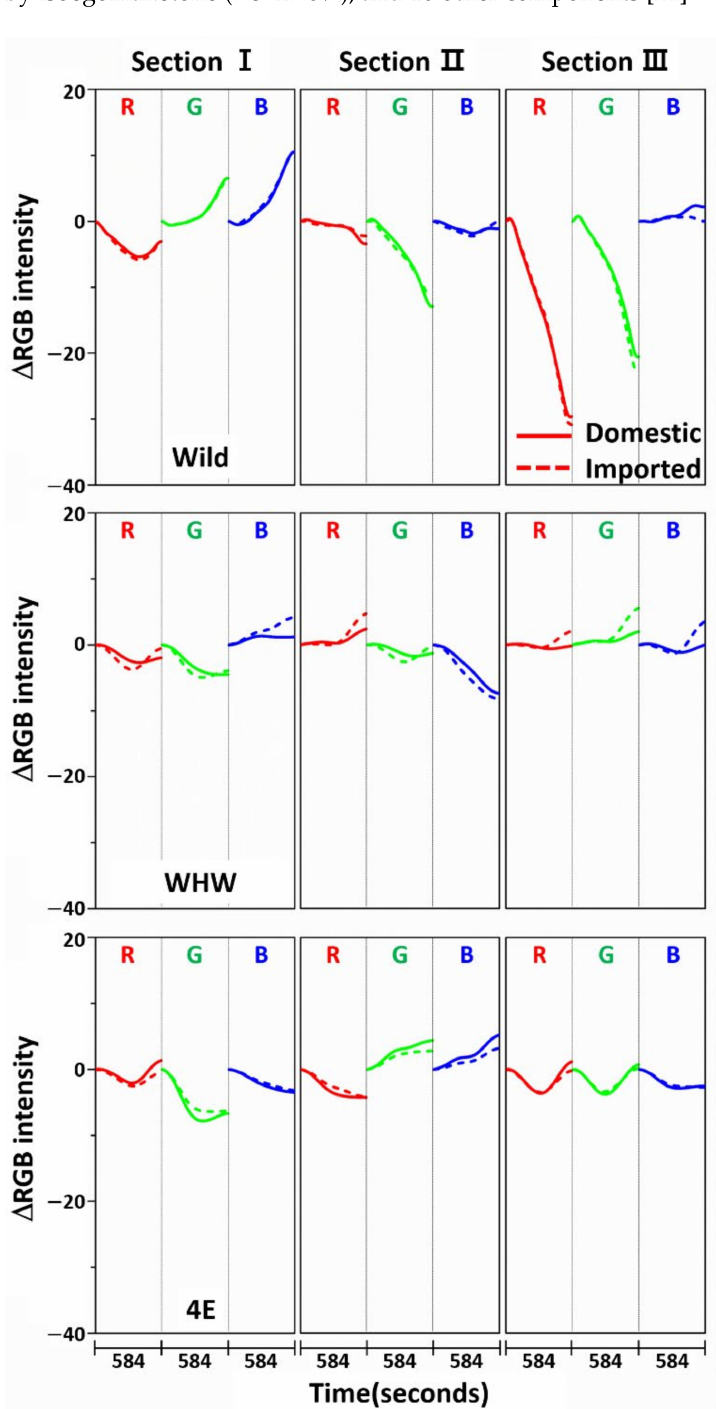
Figure 9. Average ∆ RGB intensity of perilla samples measured in the three sections of Wild, WHW, and 4E sensors. The solid and dotted lines indicate the domestic and imported samples,